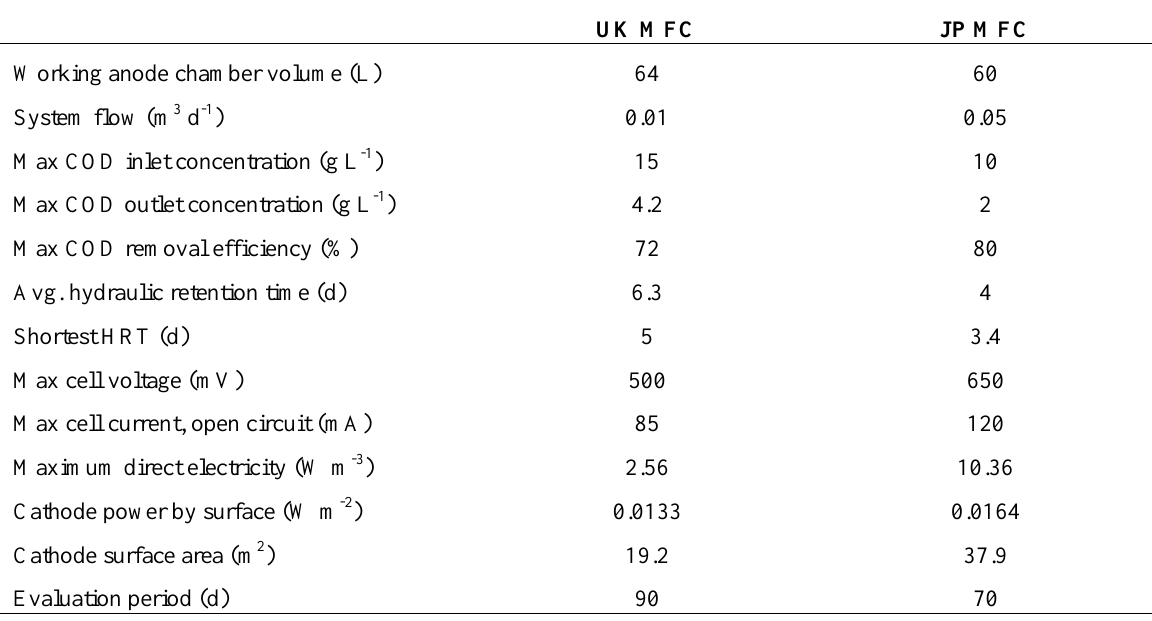
Table 1: Microbial fuel cell bioreactor